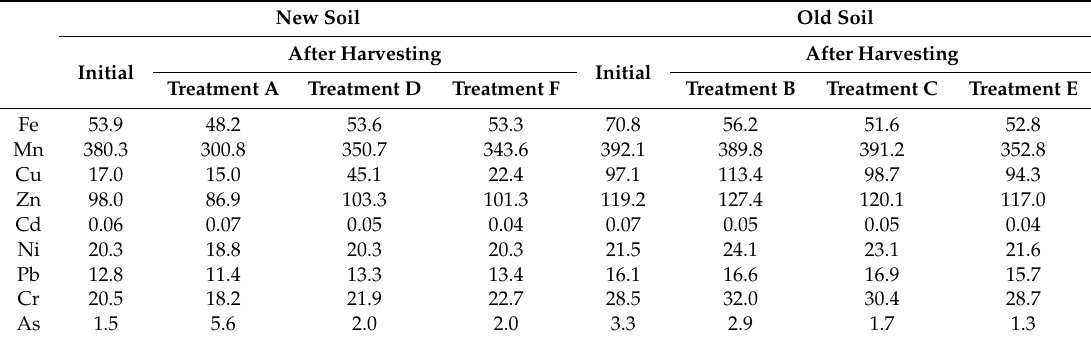
Table 6. Heavy metal contents (mg kg − 1 ) in soils before (initial) and after experiment (after harvesting).